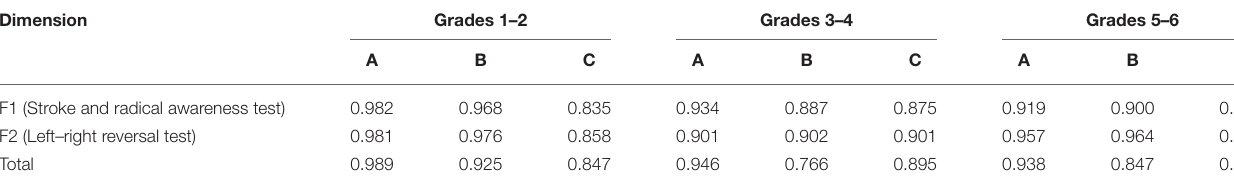
TABLE 6 | Orthographic knowledge scale for children aged 6–12 years and various dimensional coefficients.